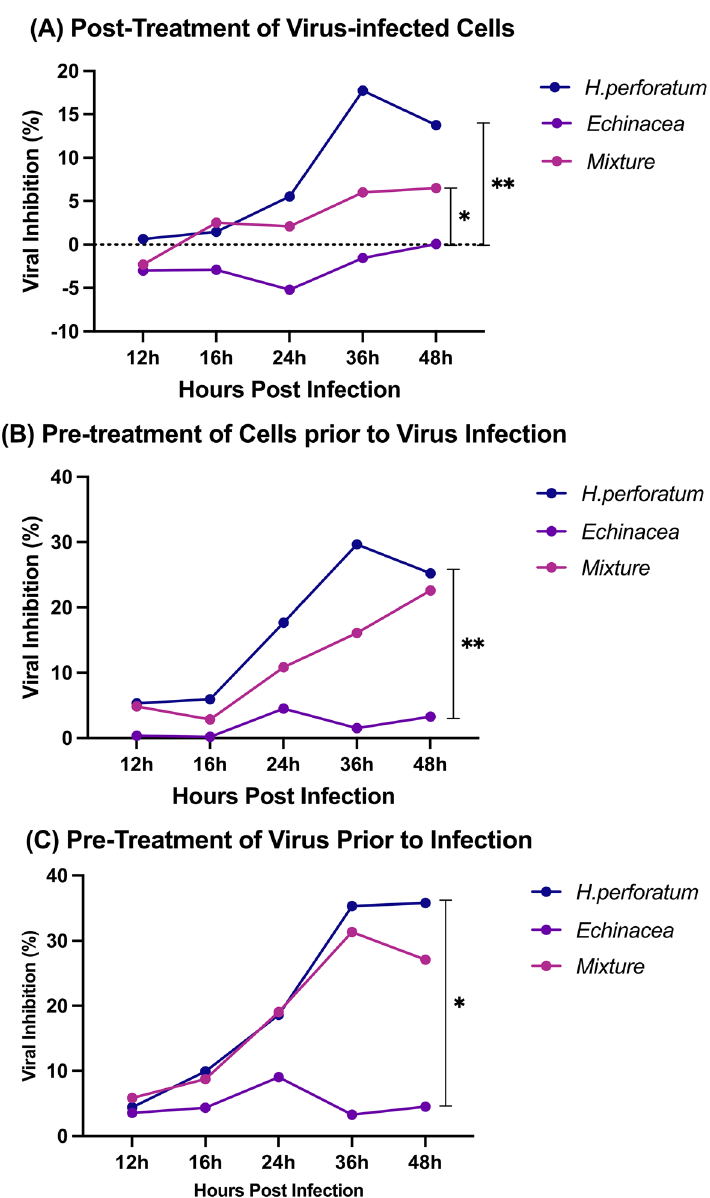
Figure 2. The inhibitory effect of H. perforatum , Echinacea , and the H. perforatum-Echinacea mixture on RNA levels of SARS-CoV-2 in Vero E6 cells was evaluated by qRT-PCR. The three experimental designs as: Post Treatment of Virus-infected Cells ( A ), Pre-treatment of Cells Prior to Virus Infection ( B ), and Virucidal ( C ) assays. The viral inhibition percentage of H. perforatum was 18, 30, and 36% up to 36 h in ( A – C ) respectively, while it was 7, 24, and 32% for the H. perforatum-Echinacea mixture, and it showed the least inhibition percentage with Echinacea up to 24 h. The inhibitory effect was representatives of two independent experiments performed in triplicate. Statistical analysis showed that differences were significant with p < 0.05 and p < 0.005 (one- & two-way